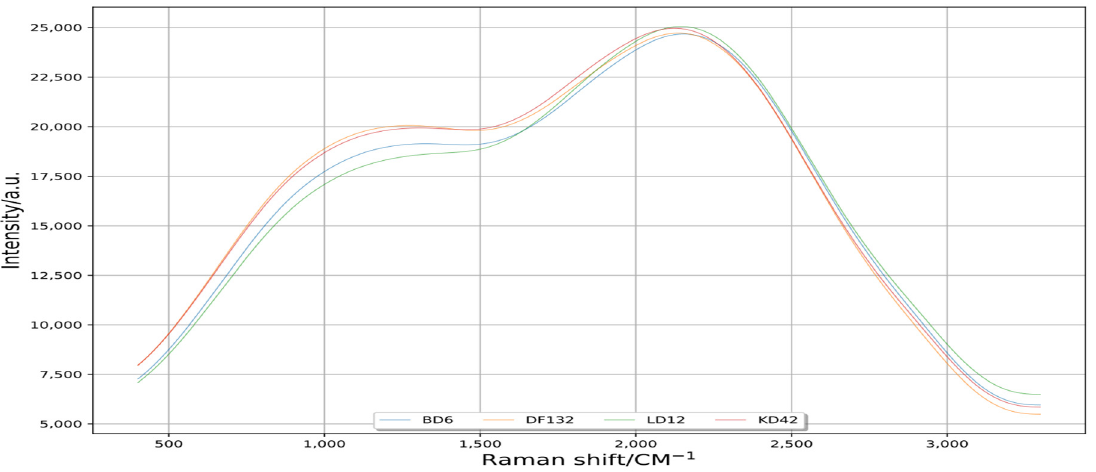
Figure 4. Spectral curves of disturbance reduction by signal filtering method. Raman shift is the reciprocal of wavelength, unrelated to the frequency of incident light, and only related to the vibration frequency of sample molecules, and its range is 200–3400 cm − 1 . Intensity is the intensity of Raman scattering, which is the anti-Stokes line; the anti-Stokes line is the scattering light of frequency shifted light from monochromatic incident light in a molecule.